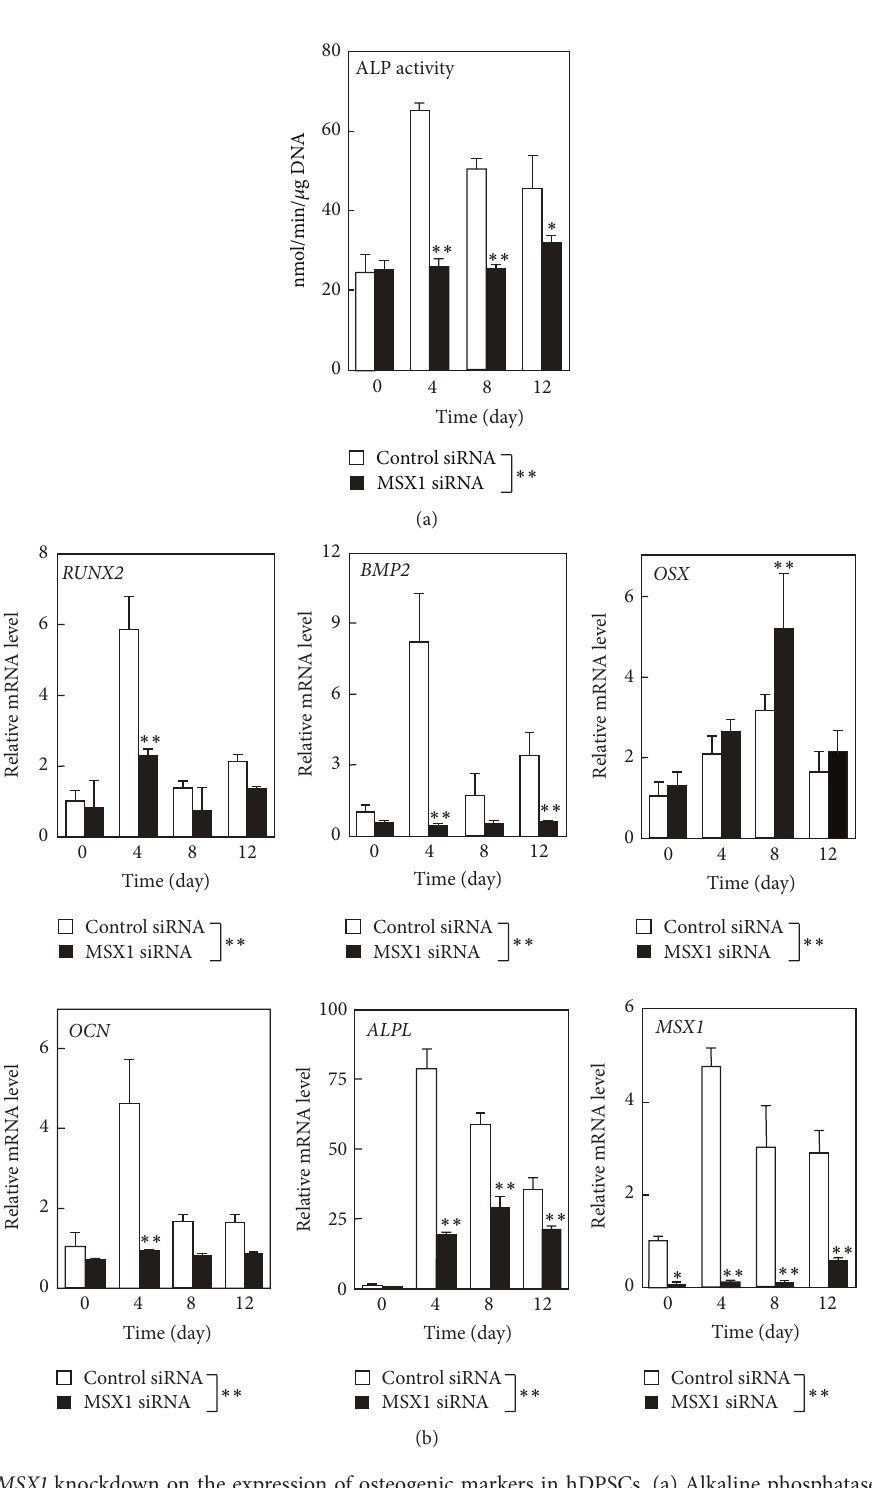
Figure 3: Effects of MSX1 knockdown on the expression of osteogenic markers in hDPSCs. (a) Alkaline phosphatase activity in cultures was determined on days 0–12 after exposure to osteogenesis-induction medium. (b) The mRNA levels of osteoblast-related genes, including RUNX2 , BMP2 , OSX , OCN , and ALPL , along with the MSX1 mRNA level were quantified by RT-qPCR on the indicated days. Values are averages ± SD for three cultures. ∗ 𝑃 < 0.05 ; ∗∗ 𝑃 < 0.01